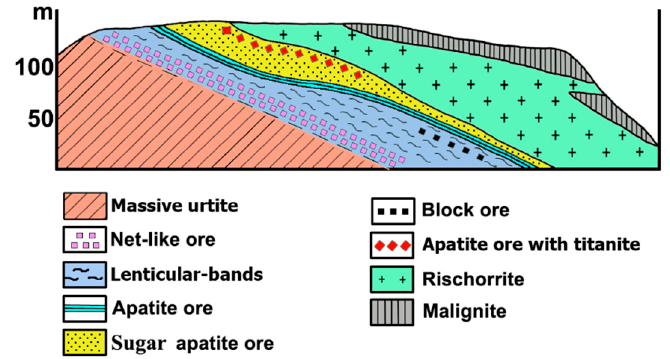
Figure 2. Cross-section of the Kukisvumchorr apatite deposit [14].